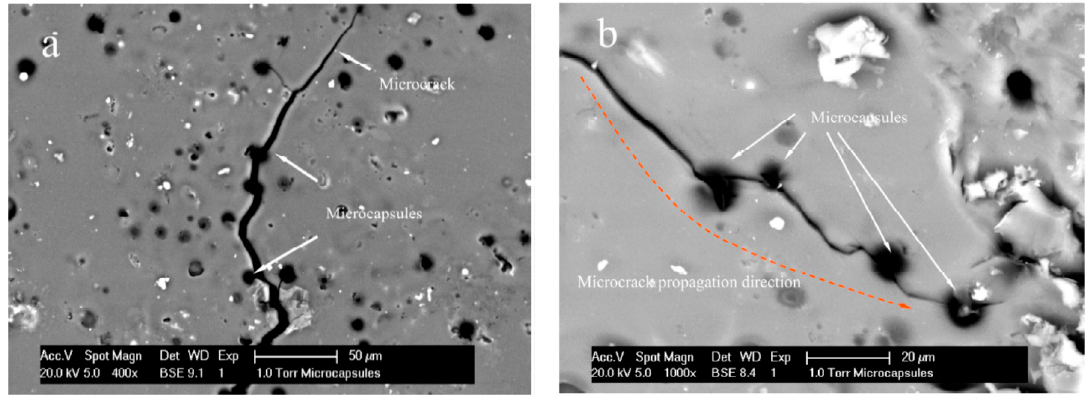
Figure 5. ESEM morphologies of microcracks in bitumen, ( a ) a microcrack propagation direction; ( b ) a microcrack punctured several microcapsules.